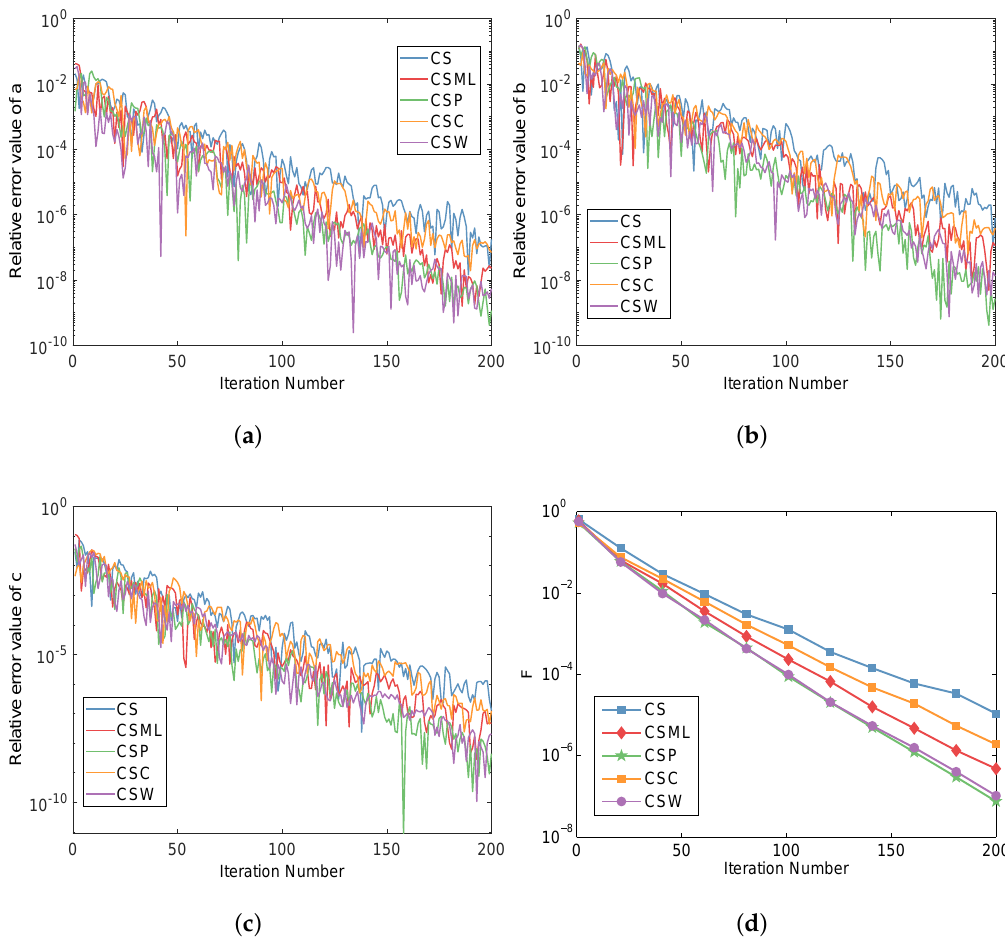
Figure 5. The convergence curves of the relative error values and objective function values for system (16). ( a ) The relative error value of a . ( b ) The relative error value of b . ( c ) The relative error value of c . ( d ) Objective function value of F